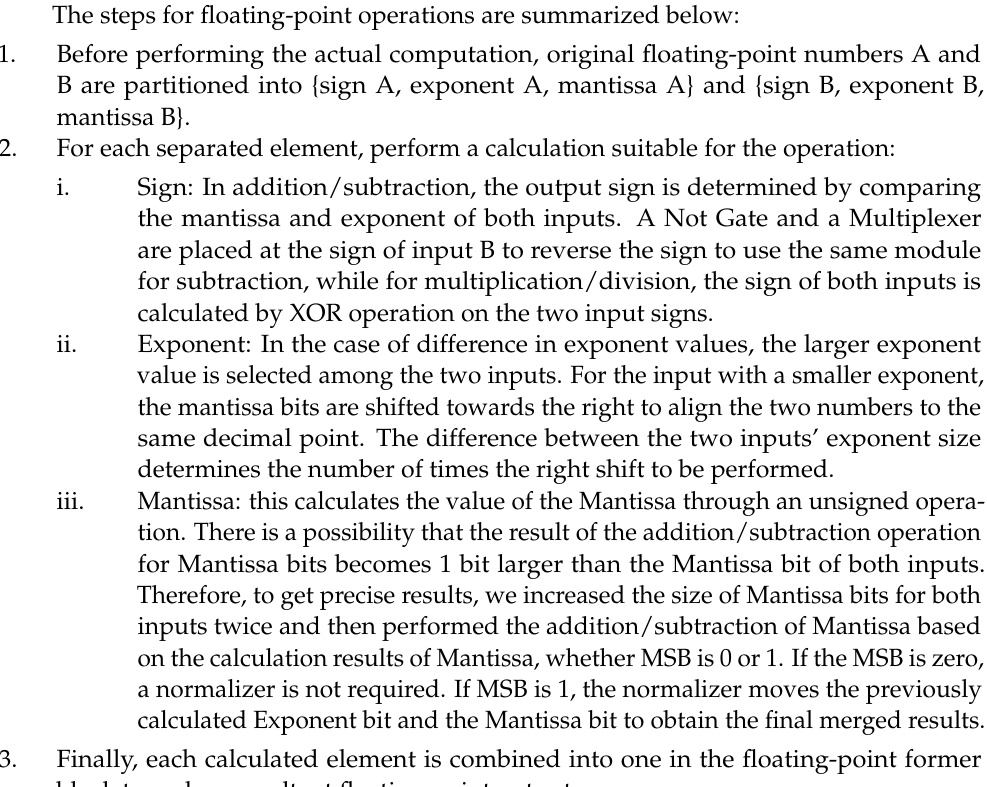
Figure 3. ( a ) General operation process. ( b ) Detailed operation process of floating point.